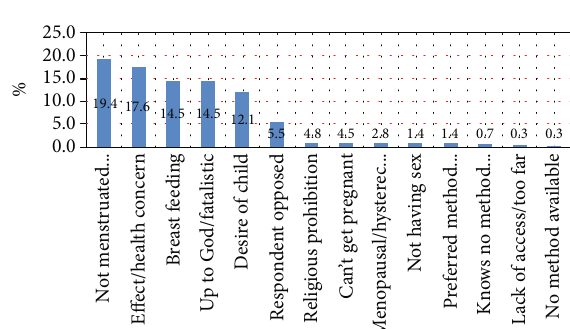
Figure 1: Reasons for not using family planning among